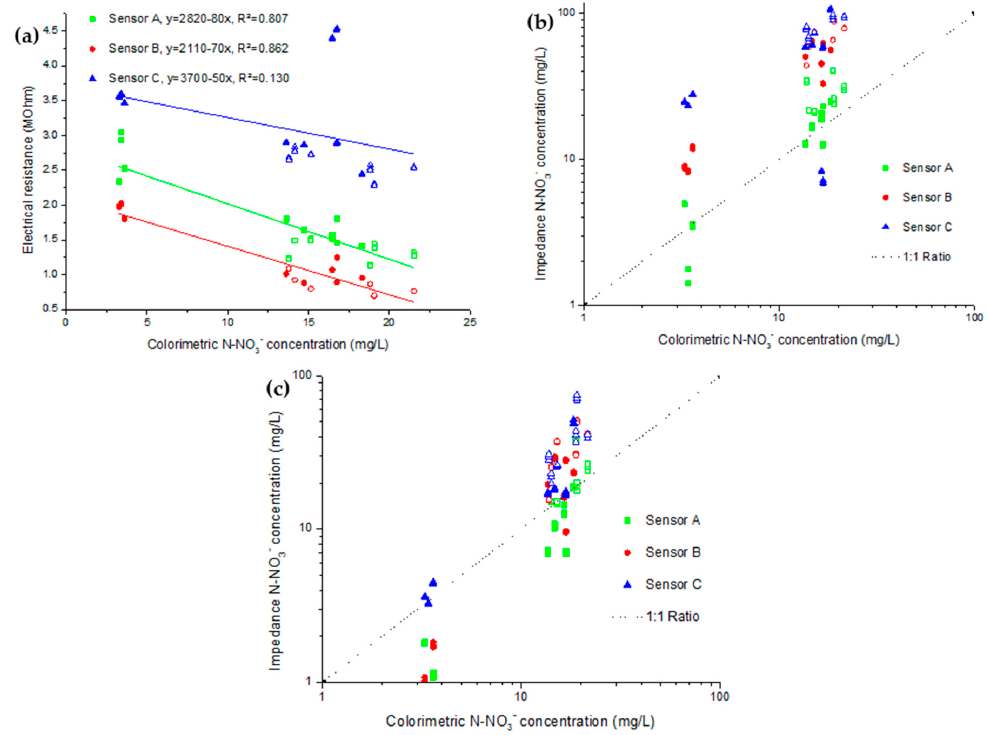
Figure 5. ( a ) Quantification of fertilization season samples by impedance measurement. Each sensor was associated to a linear regression to illustrate the linearity of the association; ( b ) illustrates